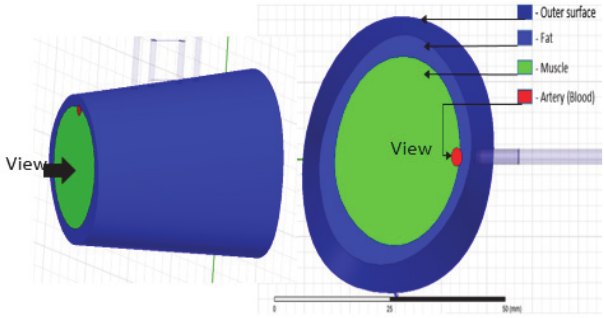
Fig.1 (a): Transverse view of the model